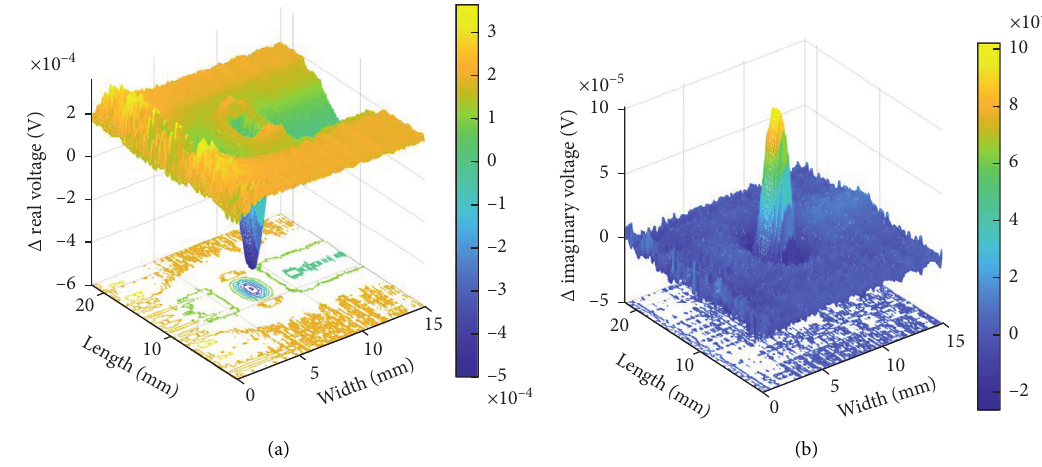
Figure 8: The (a) real and (b) imaginary parts of the detection signal for defect C1.